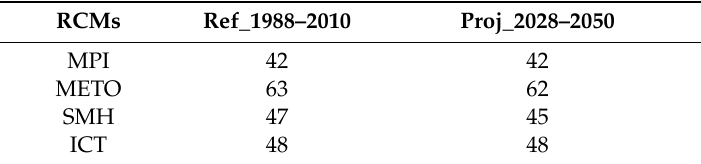
Table 2. Percentage (%) of the number of rainy days ( > 1